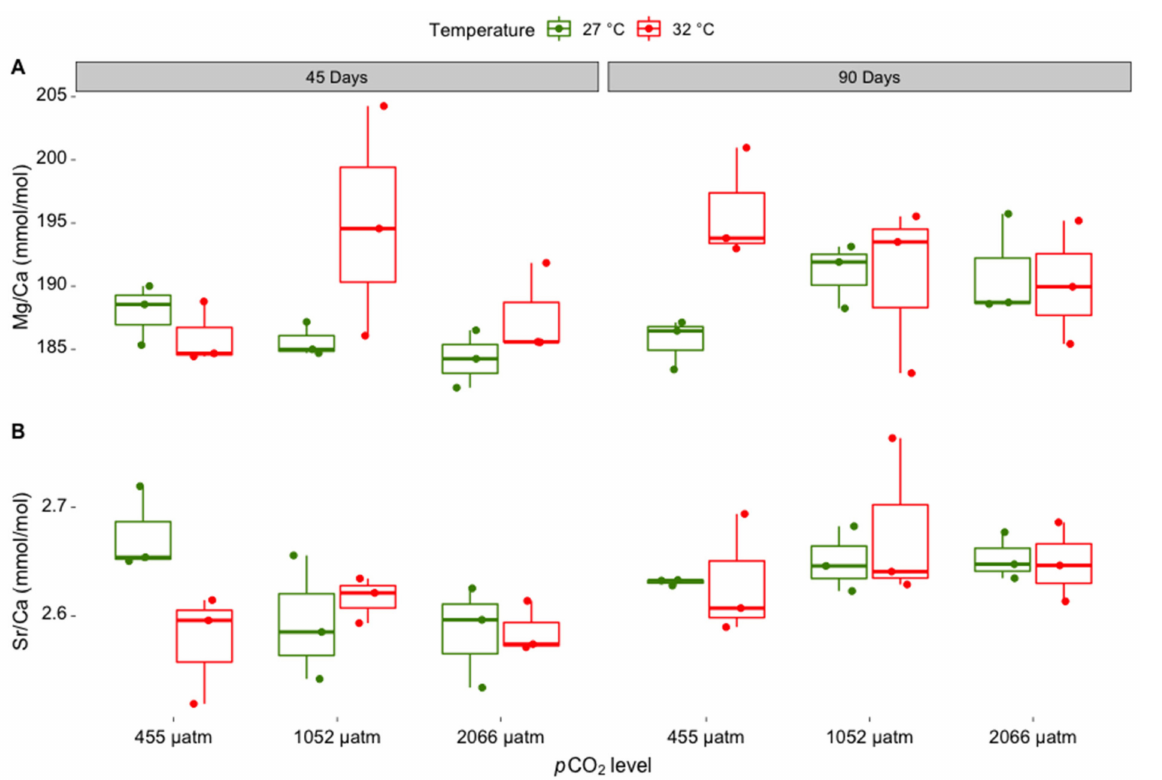
Figure 1. Changes in skeletal properties ( A ) Mg/Ca ratios (mmol/mol) and ( B ) Sr/Ca ratios (mmol/mol) of skeletal carbonate in A. yairi exposed to different temperatures (27 ◦ C and 32 ◦ C) crossed with different p CO 2 concentrations (455 µ atm, 1052 µ atm, and 2066 µ atm) measured after 45 and 90 days of incubation ( n = 36). Dots represent individual skeletal mineral values, displayed with jitter to avoid